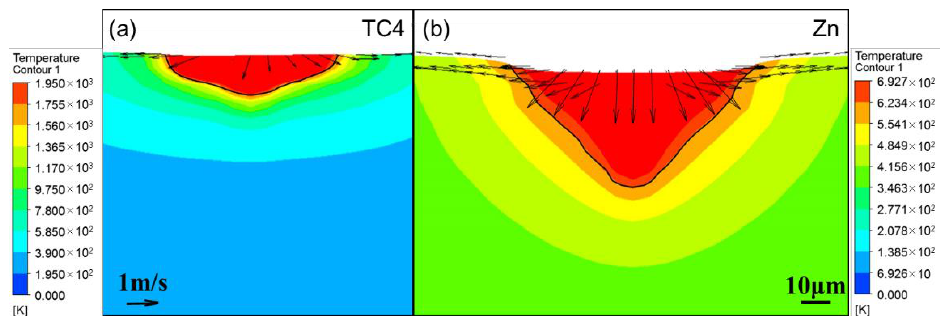
Figure 5. Dimensional values of the penetration shape of pure Zn plates.